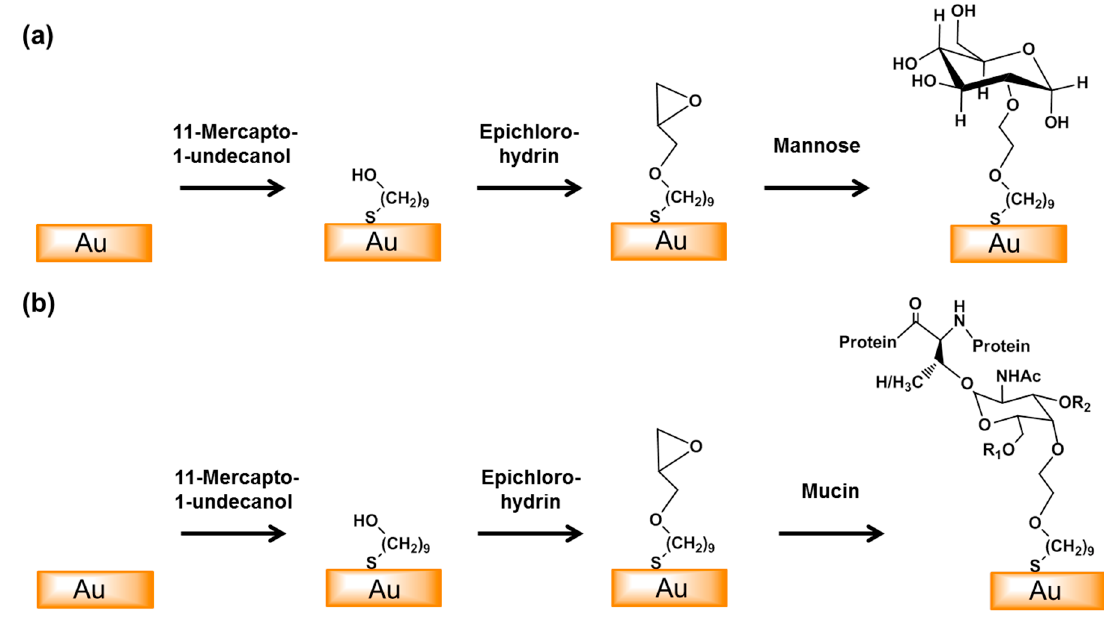
Figure 1. Schematic of the surface modification of the gold electrode with mannose ( a ) or mucin ( b ). An epoxy monolayer was formed by the self-assembly of 11-mercapto-1-undecanol on the surface of the gold electrode and this was then reacted with epichlorohydrin. Mannose and mucin were then coupled to the surface by epoxy ring opening reactions. (R 1 = β (1,6)-GlcNAc, R 2 = β (1,3)-GlcNAc).